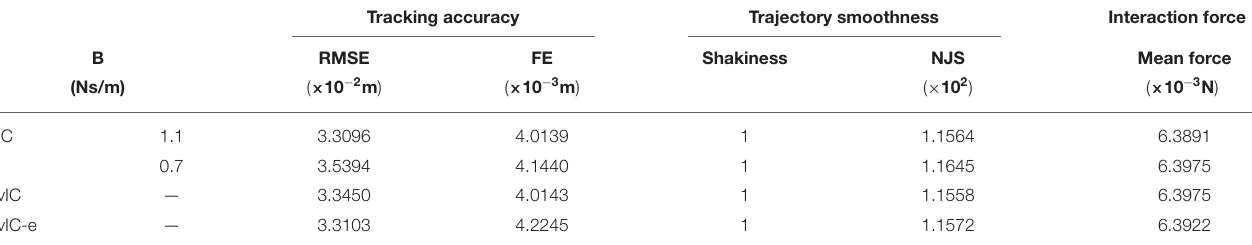
TABLE 3 | Indicators of IC, vIC, and vIC-e in